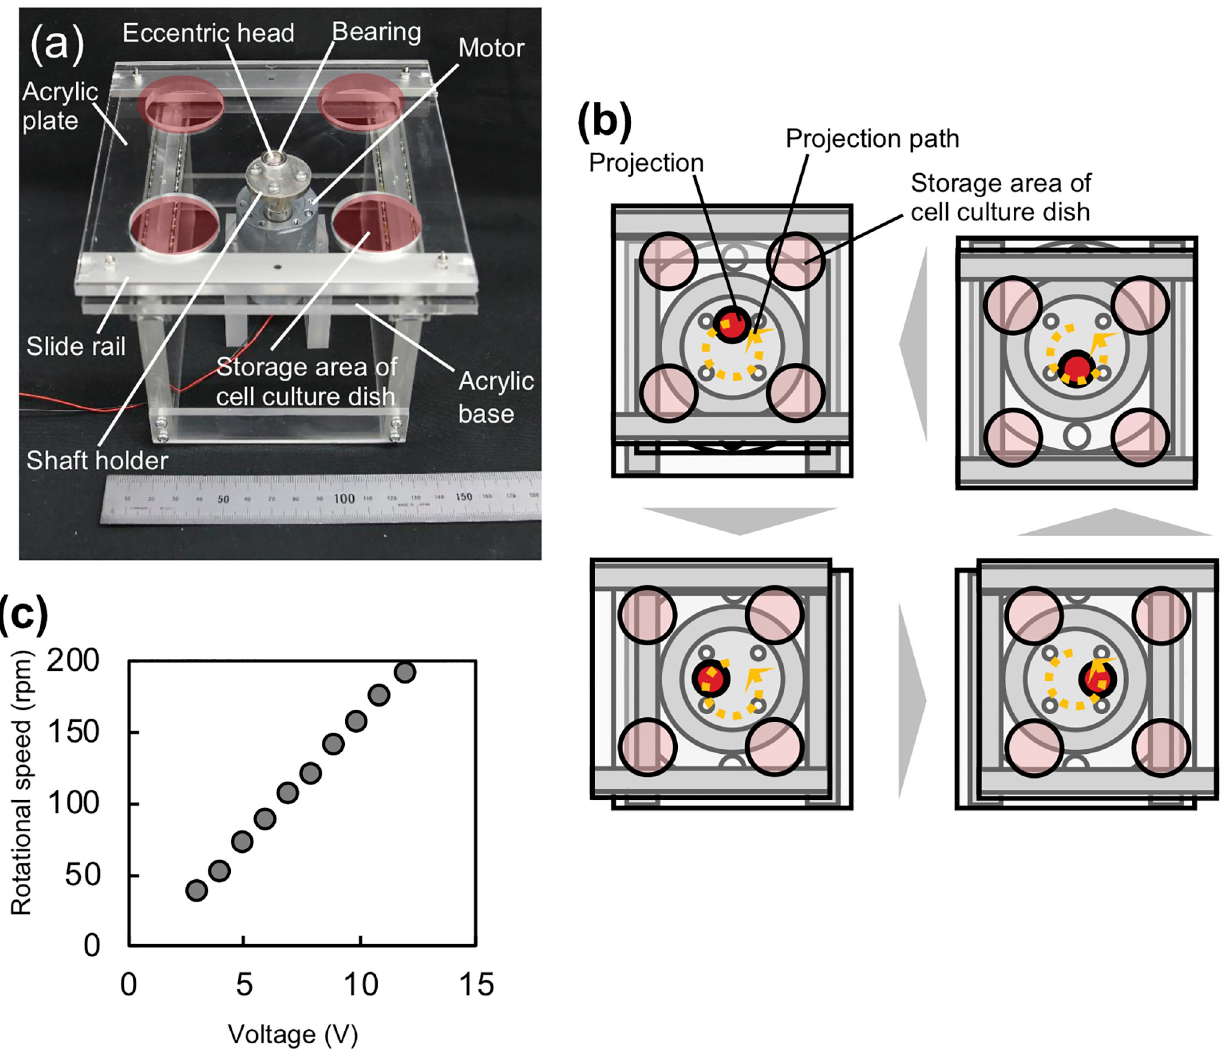
Fig 3. Details of the orbital shaking device to homogenize the initial cell density in 35-mm cell culture dishes. (a) Overall view of the device. (b) Motion of the device. (c) Relationship between the input voltage and the rotational